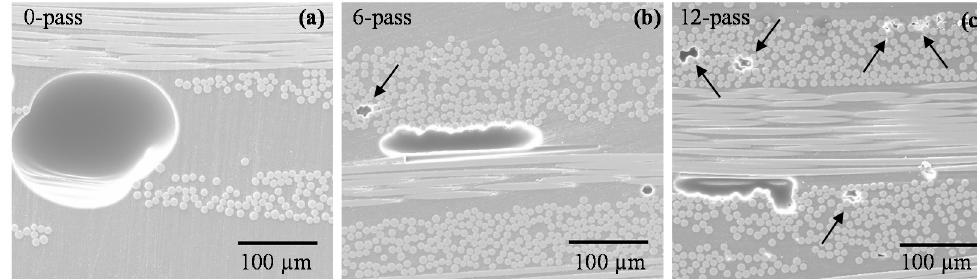
12 of 17 Figure 7. Scanning electron microscopy (SEM) images of plain weave laminates (at 35× magnification) made by WLVB process and sliding lifting magnet on the saturated lay-up with ( a ) 0 pass; ( b ) 1 pass; ( c ) 6 passes; and ( d ) 12 passes. The frequency and morphology of voids in the plain weave laminates made under different scenarios can also be seen in the SEM images of Figure 7. Since the fibers are tightly aligned, full wet out of tows are more difficult than that in the random mat, thus in addition to a number of large voids between the tows, a few small voids are seen inside the tows (see Figure 7). The presence of these large and small voids substantiates the high void content of 3.4% in conventional WLVB laminates (WLVB-PW-6-0). With increasing number of passes of magnet from 0 to 1 and 6, large voids between the tows become smaller, which decreases the overall void content (see Figure 7b–d). The increased void content in the laminates made by 12 passes compared to that in 6 passes can be explained by comparing their high-magnification SEM images. Figure 8 shows the representative